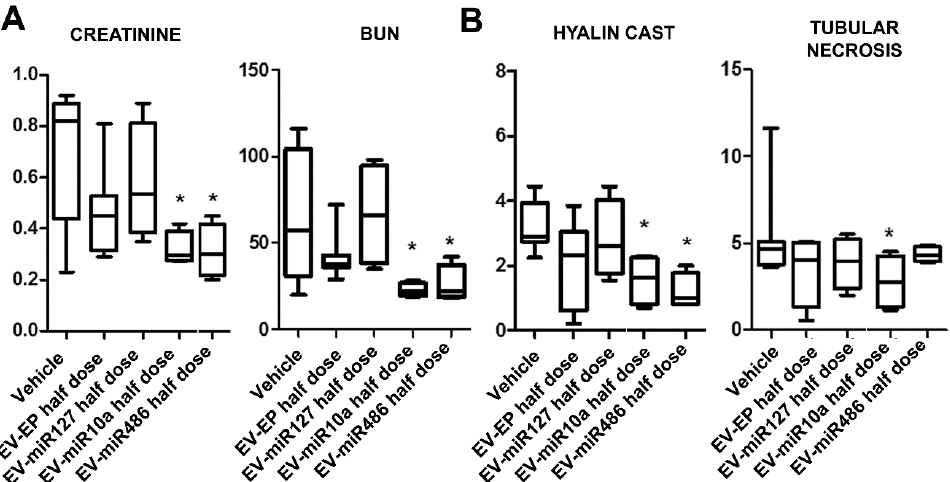
Figure 6. E ff ect of EVs derived from naïve or miRNA-enriched MSC in AKI mice: Functional and morphological evaluation. ( A ) Creatinine and BUN values in AKI mice injected with vehicle alone (Vehicle) or with 82.5 × 10 6 EVs derived from electroporated MSCs (EV-EP) and transfected with different miRNA mimics (EV-miR127, EV-miR10a, EV-miR486). EVs were injected at day 3 and mice were sacrificed at day 5 after glycerol administration. Results are expressed as mean ± SD; ANOVA with Dunnett’s multiple comparison test was performed. * p < 0.05 EV-miR10a half-dose and EV-miR486 half-dose vs Vehicle. ( B ) Morphometric evaluation of hyaline casts and tubular necrosis in AKI mice treated with vehicle alone (Vehicle) or with 82.5 × 10 6 EVs derived from electroporated MSCs (EV-EP) and transfected with different miRNA mimics (EV-miR127, EV-miR10a, EV-miR486). Results are expressed as mean ± SD; ANOVA with Dunnett’s multiple comparison test was performed. * p < 0.05 EV-miR10a half-dose and EV-miR486 half-dose vs Vehicle for hyaline cast; * p < 0.05 EV-miR10a half-dose vs. Vehicle, for tubular necrosis.